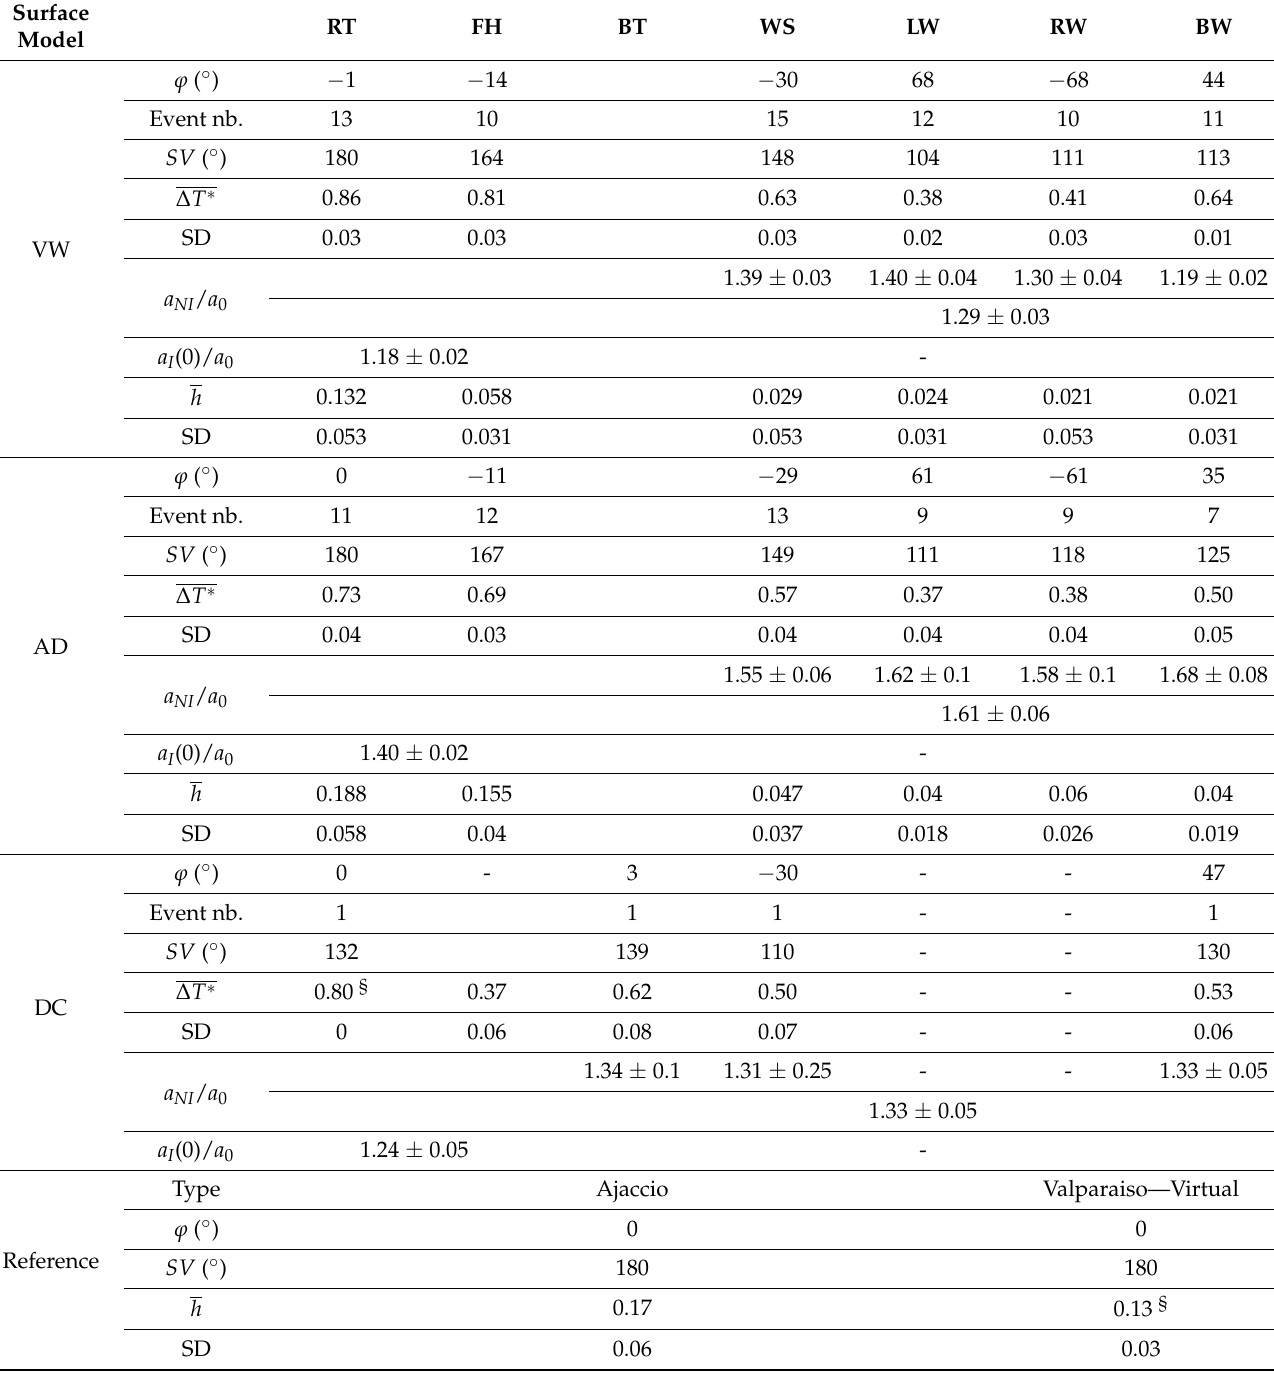
Table 5. Tilt angles ϕ , sky view SV and cooling efficiencies ∆ T ∗ according to the different condensing surfaces for three different vehicles. SD: standard deviation. (§): virtual reference computed in Section